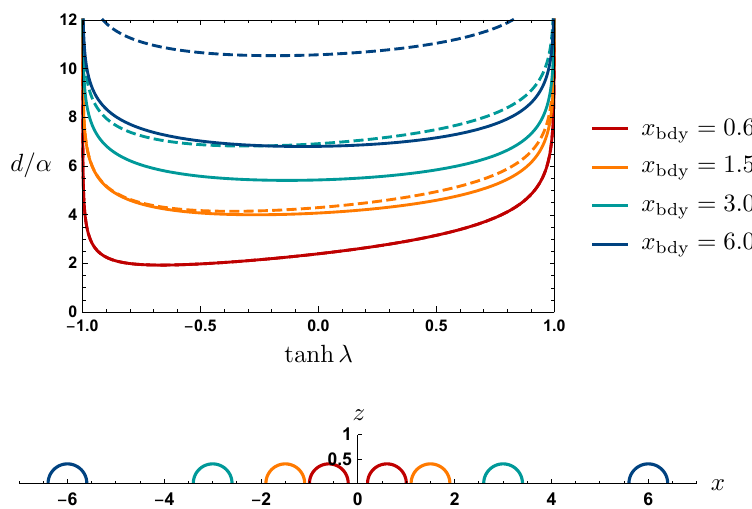
Figure 4 . Wormhole construction described in text, where we identify pairs of geodesics within the dust-free portion of the spacetime, for several choices of spacing x bdy . In this example, we choose the dust to begin at (cid:22) z = 1 and let the geodesics reach a depth of z bdy = 0 : 5, so that each subtends an x -coordinate distance of 1 in the boundary. The wormhole width function d ( (cid:21) ) is plotted in the case of a spacetime with m = 0 : 9 dust for z > 1 (dotted lines) and for pure AdS (solid lines). We see that the dust enlarges the girth of the wormhole, as expected.